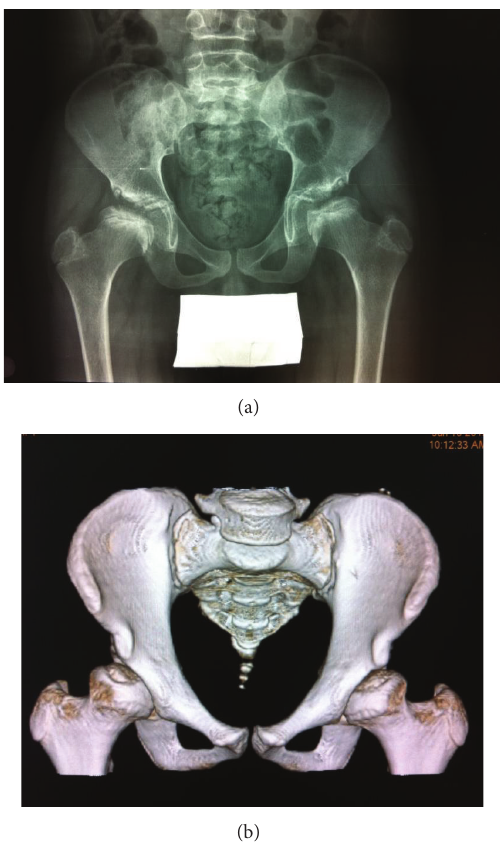
Figure 1: (a) First pelvic X-ray: dysplastic appearance of both femoral heads and irregular upper contour of the acetabular roof with mild coxa vara. (b) Last pelvic CT scan (three-dimensional volume-rendered reformatted picture): almost total reconstruction of anatomic